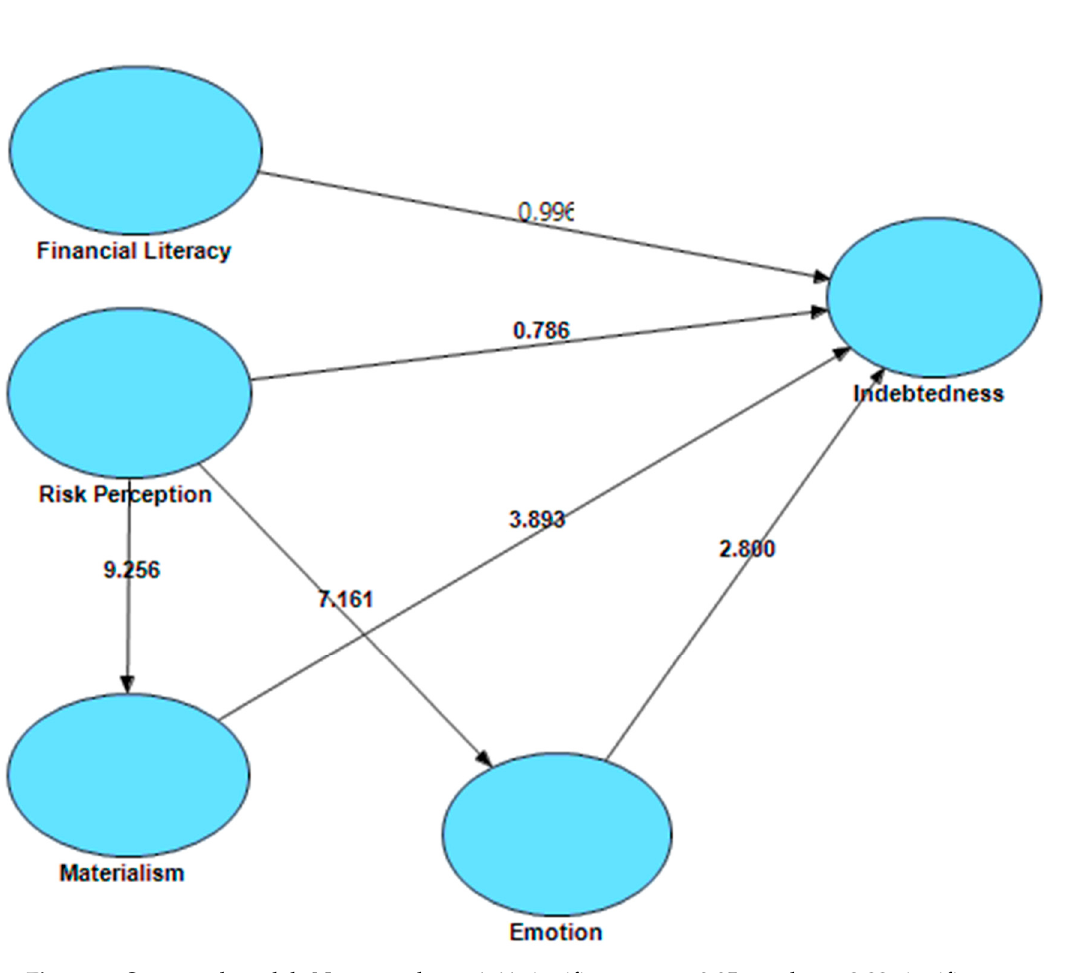
Figure 3. Structural model. Note: t -value ≥ 1.64 significant at p < 0.05, t -value ≥ 2.32 significant at p < 0.01.